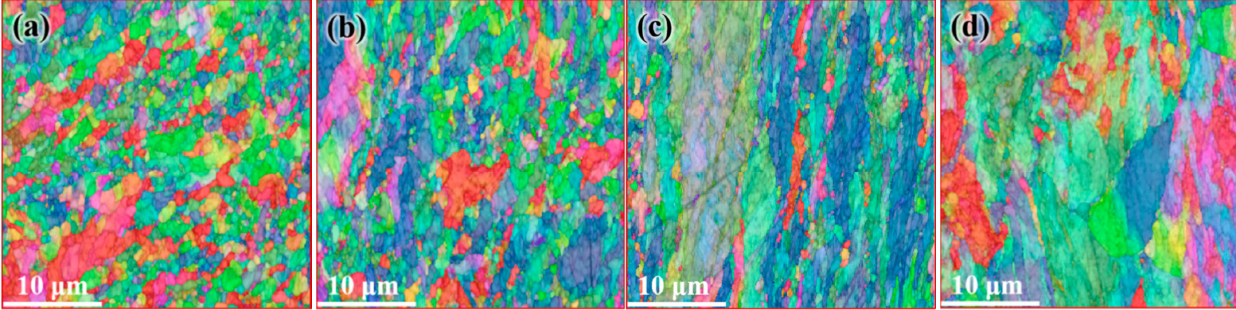
Figure 14. Distribution of microstructure after FCE at room temperature: ( a ) 250 µ m from the edge, ( b ) 1 mm from the edge, ( c ) 2 mm from the edge, and ( d ) 3 mm from the